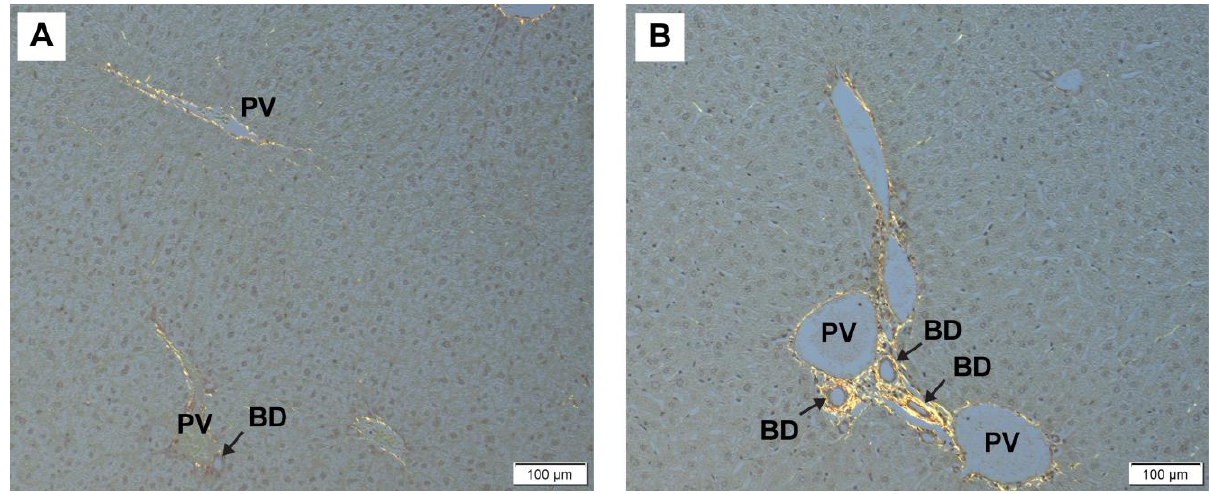
FIGURE 2: Representative photomicrographs of picrosirius red staining in the livers from mice colonized with stool from 2-week-old infants born to (A) normal-weight and (B) obese mothers. Black arrows indicate bile ducts. BD, bile duct; PV, portal vein. Sections of liver were collected and fixed in 10% formaldehyde and transferred to 70% ethanol until embedded in paraffin and processed on slides for picrosirius red staining. All staining was completed by the University of Colorado Cancer Center Research Histology Shared Resource. Im- ages were captured on an Olympus BX53 microscope using cellSens software and DP27 camera (Olympus). All animal studies were ap- proved by University of Colorado Institutional Animal Care and Use Committee (protocol number